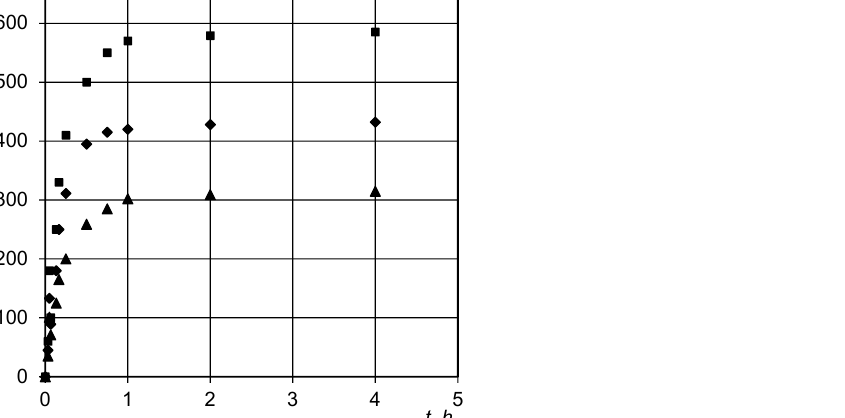
Figure 5. The influence of contact time on diazepam concentration uptake by activated charcoal, for different initial concentrations; T = 37.0 ± 0.1 °C; pH = 6.80 ± 0.05; ■ C i = 0.7 mg/mL; ◆ C i = 0.5 mg/mL; ▲ C i = 0.3 mg/mL; and S:L ratio = 1 g/L.